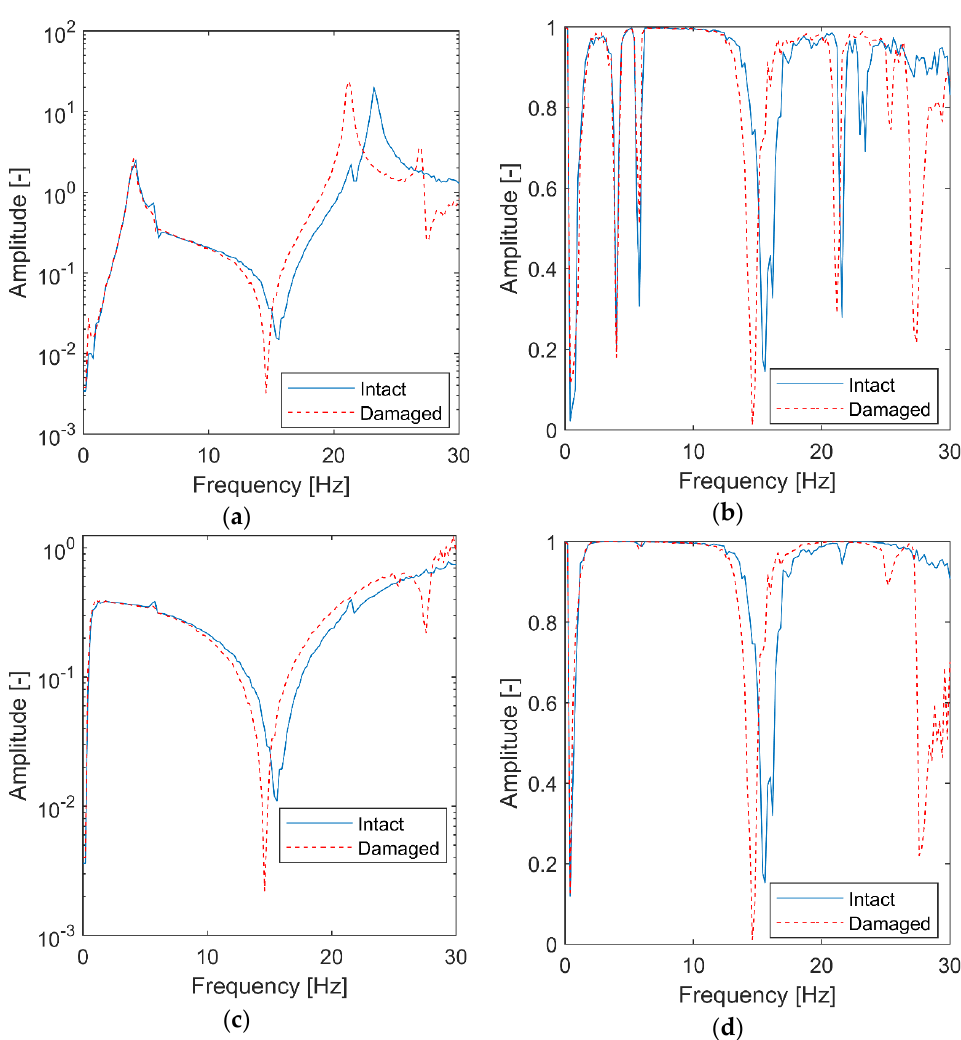
Figure 8. Classical analysis for the three-floor building: ( a ) FRF in a logarithmic scale; ( b ) FRF coherence; ( c ) transmissibility; ( d ) transmissibility coherence.